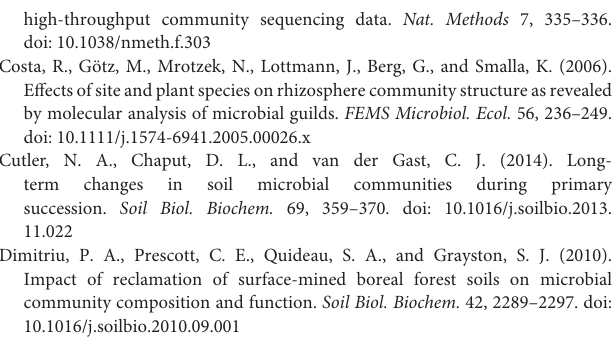
Figure S1 | The location of Study sites. Figure S2 | Soil microbial richness rarefaction curves in the reclaimed mining area. (A) Bacteria. (B) Archaea. (C)